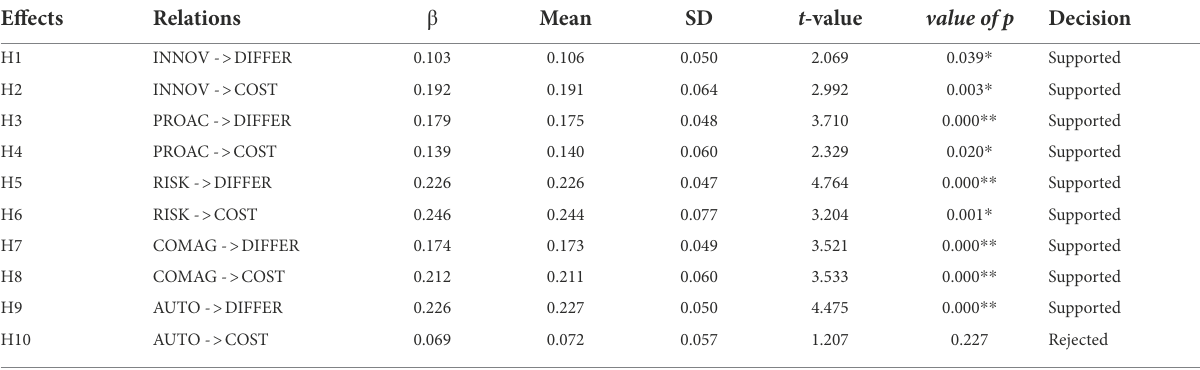
TABLE 6 Hypothesis